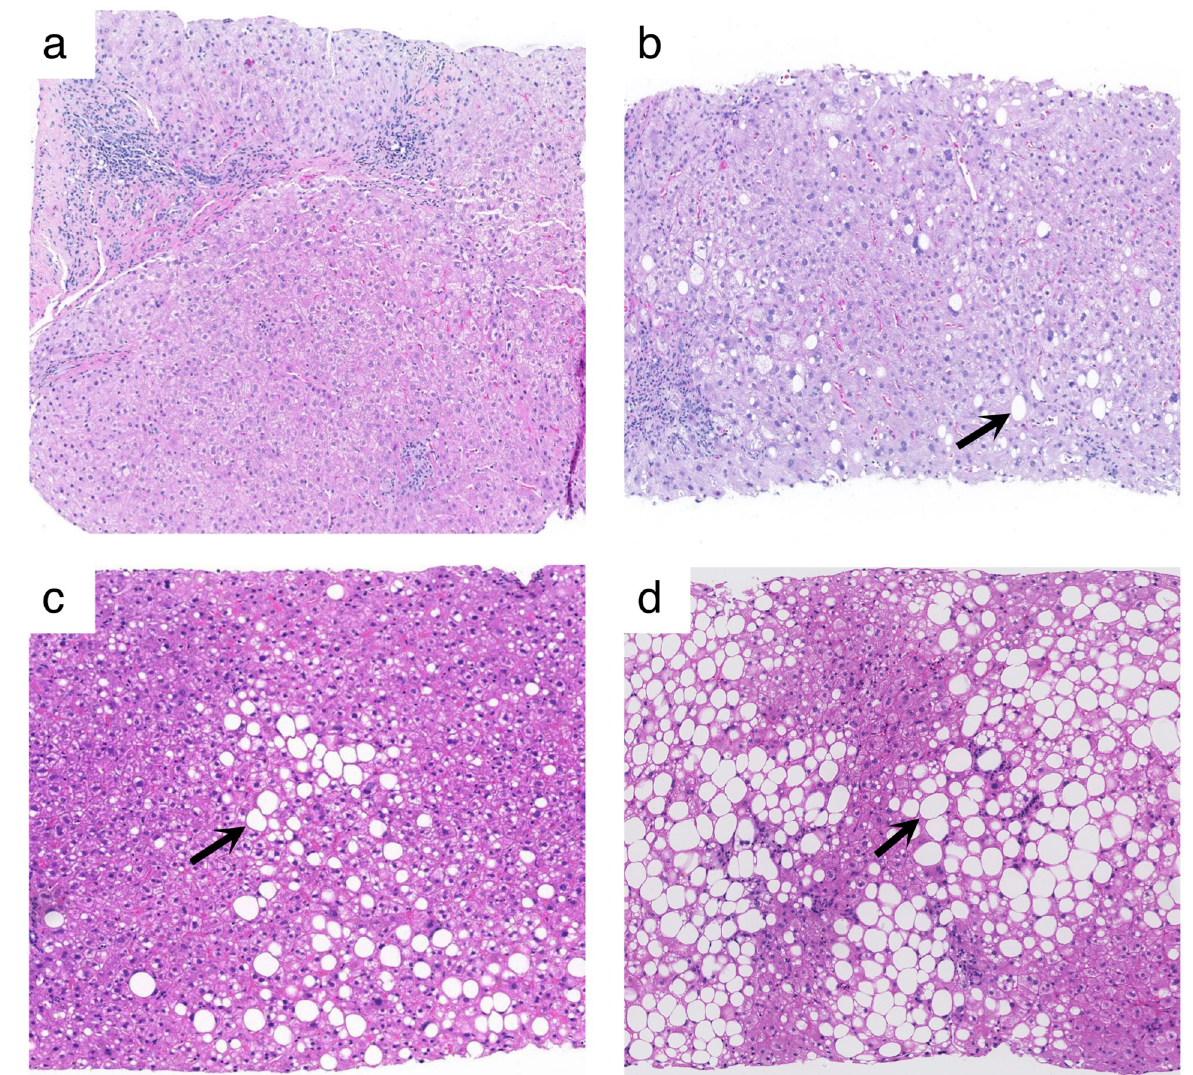
Fig 4. Examples of histopathology slides. Hematoxylin and eosin-stained images (10x magnification) in 4 different patients corresponding to those shown in Fig 1 above: (A) steatosis grade S0, (B) steatosis grade S1, (C) steatosis grade S2, and (D) steatosis grade S3. Representative vacuoles of macrovesicular steatosis are indicated by